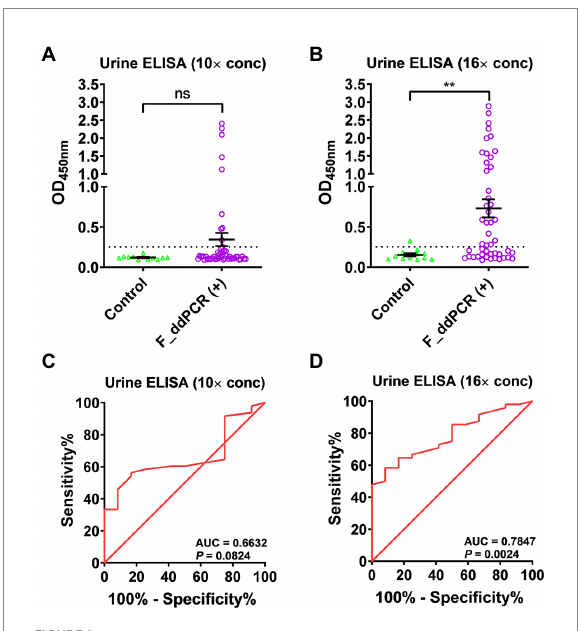
FIGURE 1 Determination of the optimal loading volume of concentrated (20×) urine samples for the SjSAP4 + Sj23-LHD-ELISA assay. (A,B) Scatter plots showing the IgG responses in 50 (A) and 80 μ l (B) urine sample, respectively, to the S. japonicum antigen combination SjSAP4 + Sj23-LHD. Healthy controls ( n = 12), F_ ddPCR-positives ( n = 48). p values were determined using the Mann–Whitney U -test. ns, no significant difference; ** p < 0.01. (C,D) Receiver operating characteristic curve (ROC) analysis was performed to evaluate the capability of the urine ELISA in discriminating the healthy control group ( n = 12) and F_ddPCR- positives ( n = 48). Fifty μ l (C) and 80 μ l (D) concentrated (20×) urine samples were loaded on the plate during the ELISA assay,